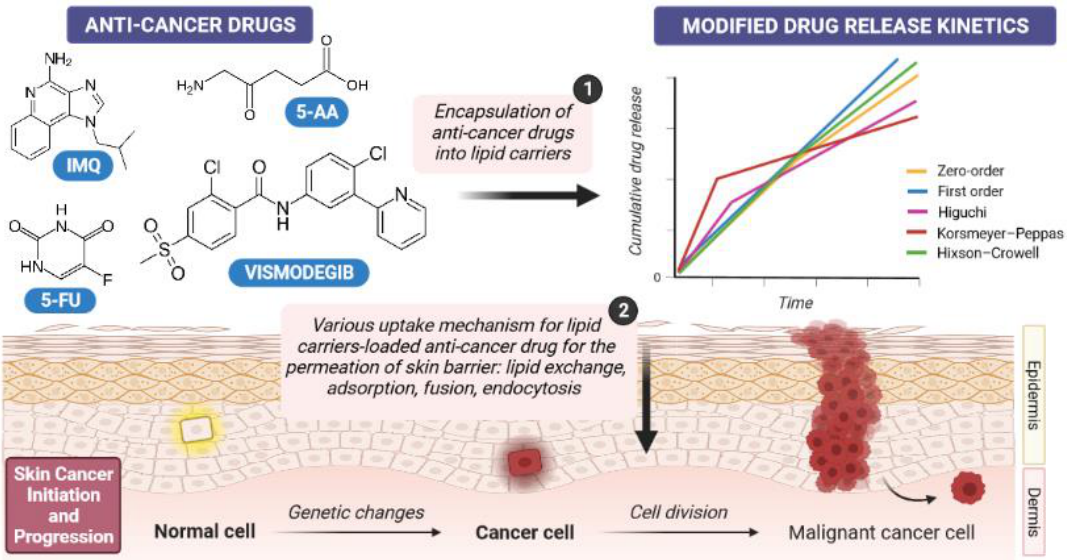
Figure 4. Scheme of targeted anticancer drug delivery using lipid nanocarriers (1), modified drug release kinetics, and various uptake mechanisms for skin barrier permeation (2). Below, a malignant cancer cell progression is shown (own drawing).